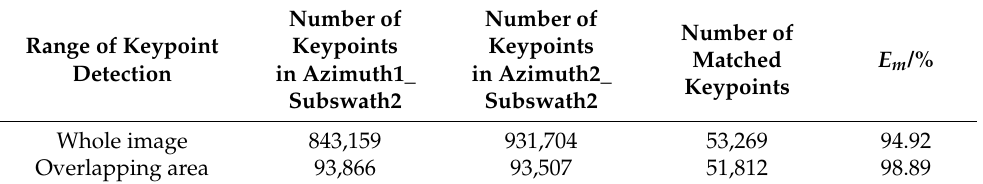
Table 2. Keypoint detection and matching performances of the whole images and overlapping areas.